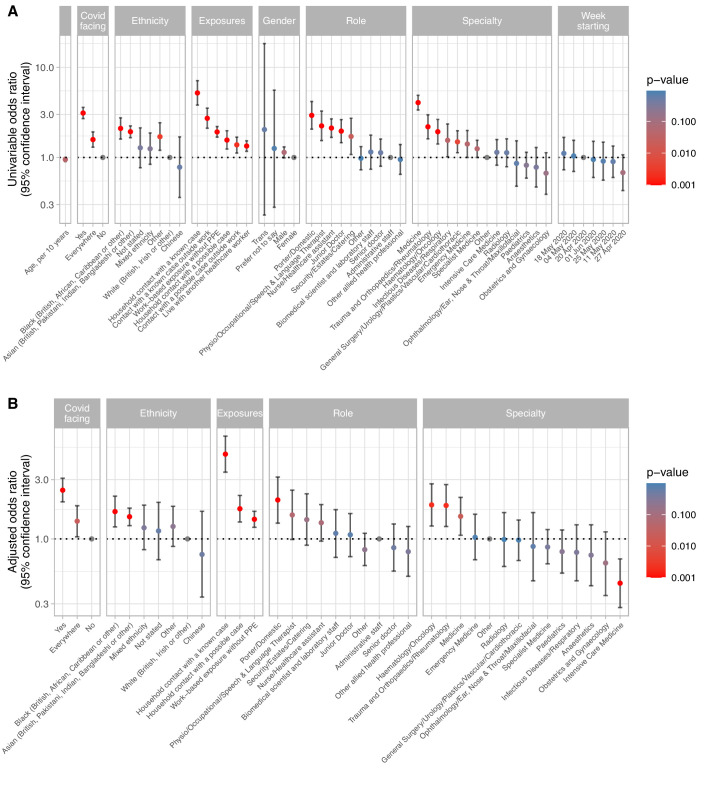
Univariable (panel A) and multivariable (panel B) relationships between risk factors and staff infection with SARS-CoV-2 in 10,032 healthcare workers.See Supplementary file 1B for count data, univariable and multivariable odds ratios. Pairwise interactions were sought between all variables the multivariable model, a single interaction exceeded the p<0.01 screening threshold, representing decreased risk of Covid-19 in emergency department staff reporting exposure to a Covid-19 without PPE (p=0.002). However, given the large number of interactions sought and biological implausibility, the interaction is omitted from the model presented. For the purpose of plotting p values <0.001 were rounded up to 0.001. Risk factor data were not available for two staff members. In panel A, the category for 01 June also includes 31 staff tested on 08 June.